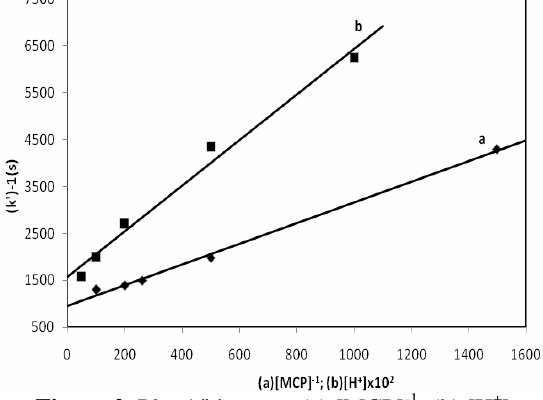
Figure 2 . Plot 1/k’ versus (a) [MCP] -1 ; (b) [H +